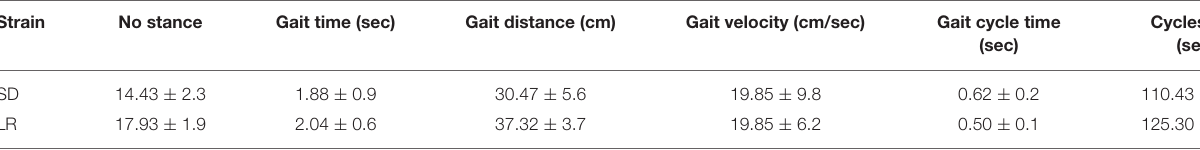
TABLE 2 | Values for # of stance, gait time, gait distance, gait velocity, gait cycle time, and cycle min. Strain